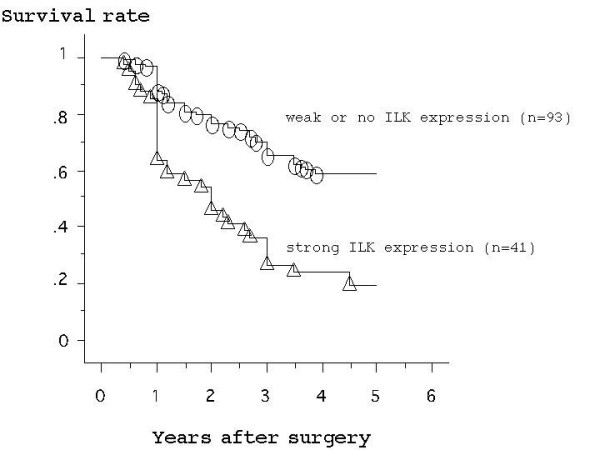
Overall survival curves for patients classified according to expression of ILK. Five-year survival rates were 20% and 59% for patients in the strong ILK and weak or no ILK groups, respectively. A log-rank test revealed a significant difference between the two groups (p < 0.001).